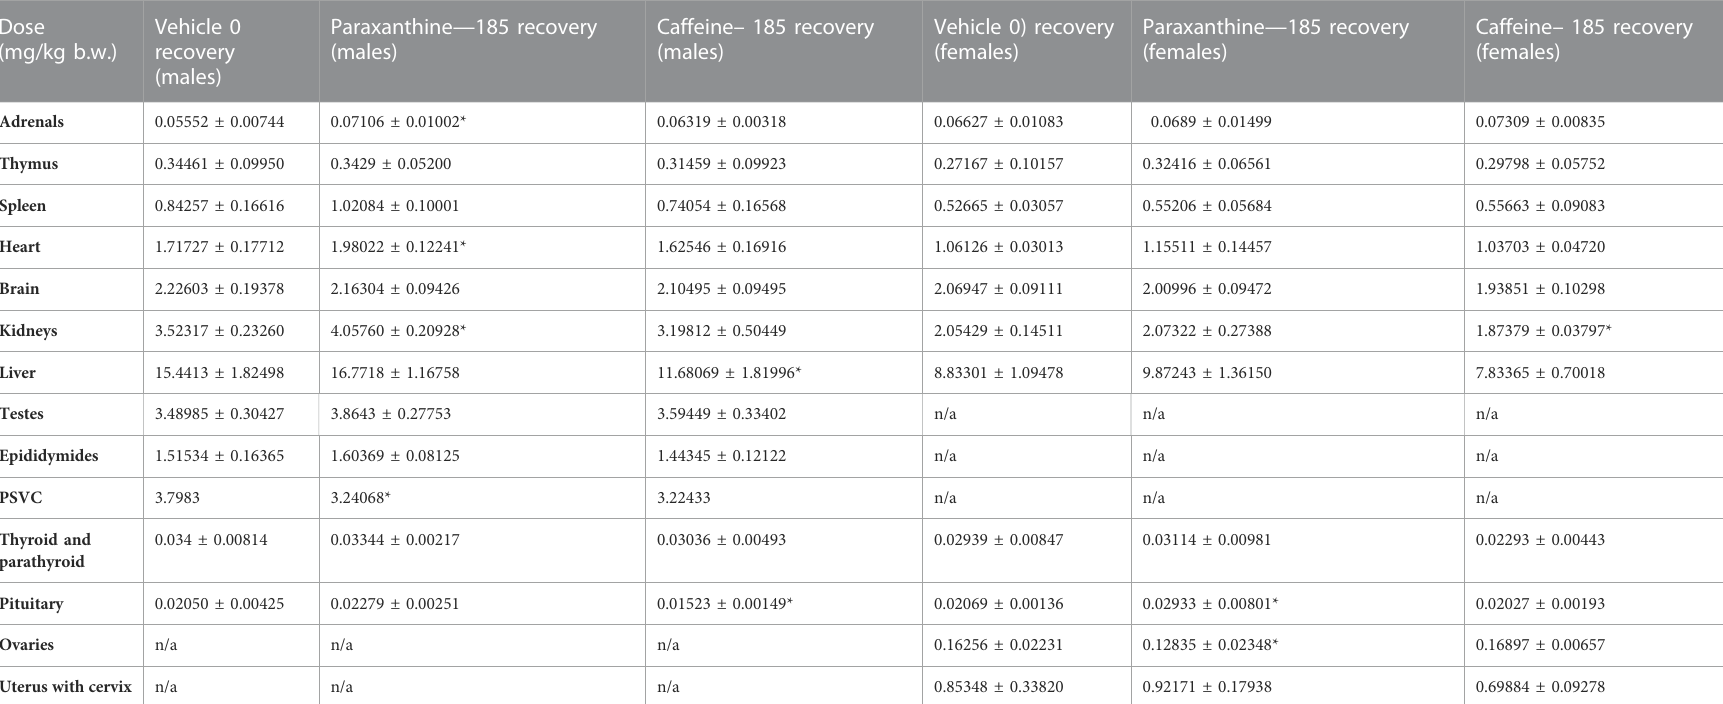
TABLE 8 Summary of absolute organ weights for recovery group males and females in the repeat-dose 90-day toxicity study. Values represent mean ± SD. *Statistically signi fi cant ( p < 0.05) with respect to the vehicle group. Dose (mg/kg